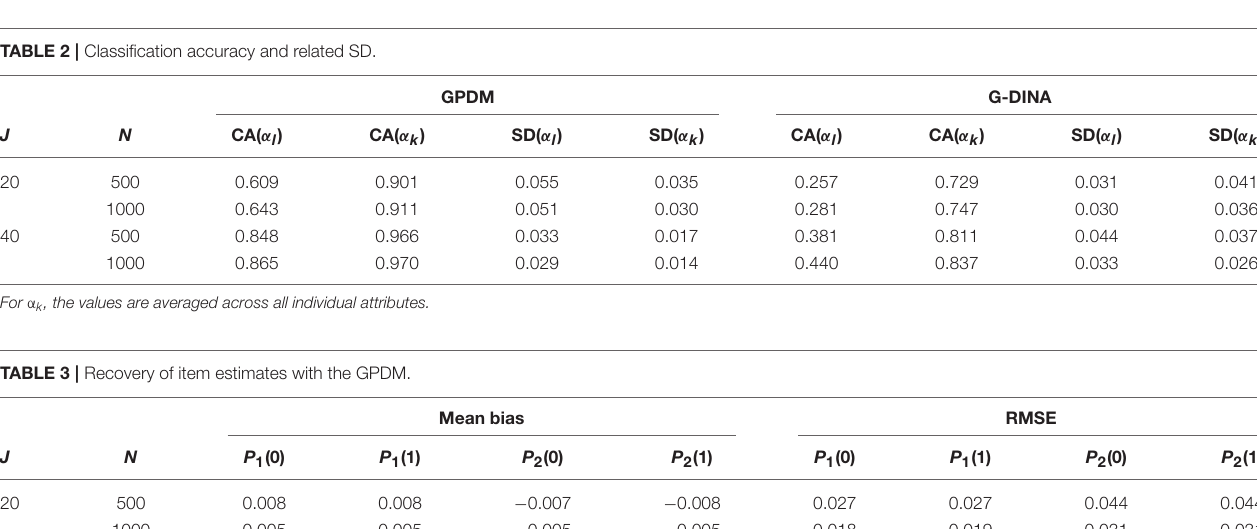
TABLE 2 | Classification accuracy and related SD.